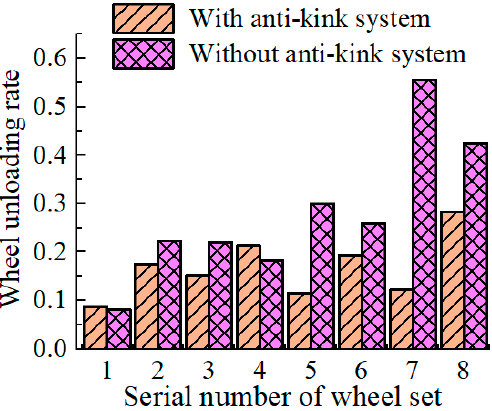
Figure 11. Wheel unloading rate.